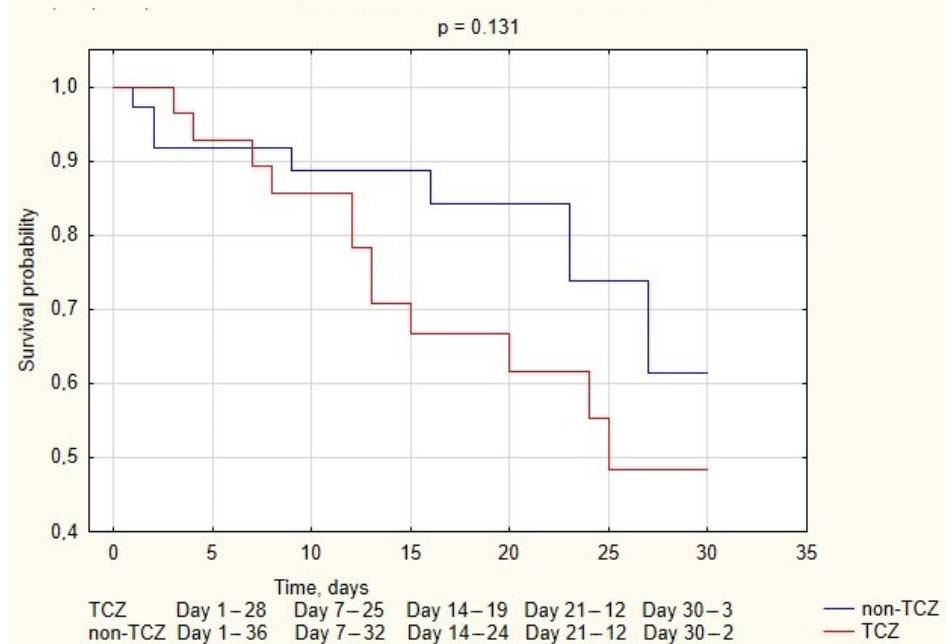
Figure 2. Kaplan-Meier curves displaying the estimated survival probability for TCZ-related treat- ment.